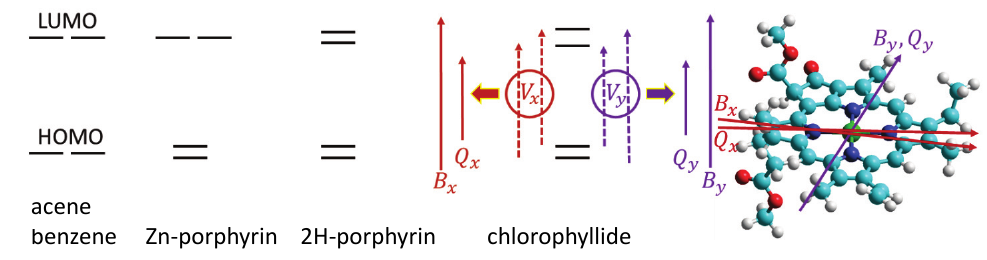
Fig. 2. Basic Gouterman model for the spectroscopy of porphyrins and chlorophylls and its relationship to benzene and the acenes. Increasing degrees of asymmetry split the doubly degenerate HOMO and LUMO orbitals of benzene, with the visible-region spectroscopic transitions 𝑄 , 𝑄 , 𝐵 , and 𝐵 (solid arrows) arising after strong configuration interactions 𝑉 𝑦 𝑥 𝑦 𝑥 the embodied single-electron transitions (dashed arrows). The directions of the associated (approximately in plane) transition dipole moments calculated by CAM-B3LYP are indicated in the molecular model for methyl-chlorophyllide-a: C – cyan, H – white, N – blue, O – red, Mg –